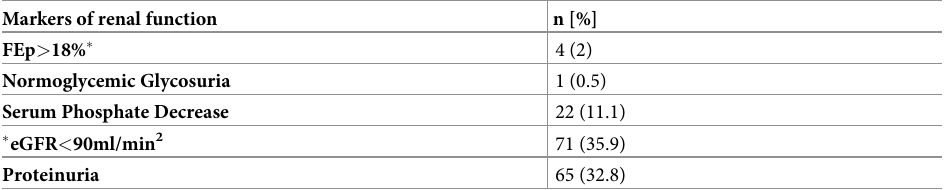
Table 3. Proximal renal tubular function; urinary and serum biomarkers and glomerular function abnormalities of HIV infected children, on TDF for at least 6 months, < 18 years. Markers of renal